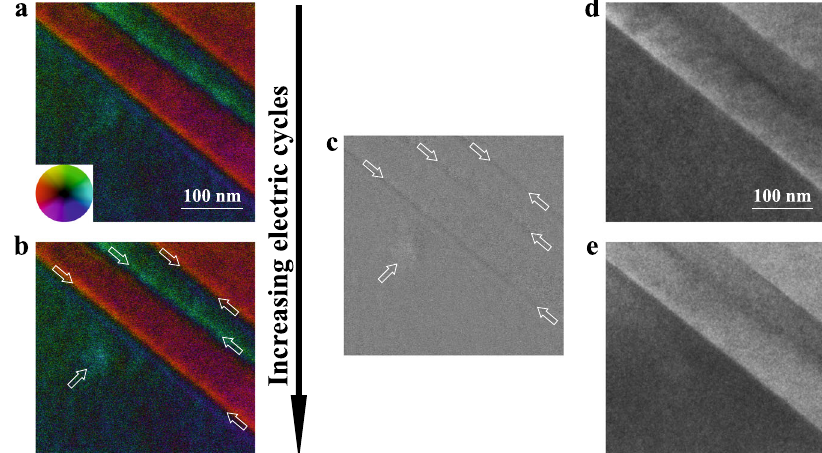
Fig. 3 Charge accumulation at domain walls during cyclic electric loadings. a , b Electric fi eld mapping before and after cyclic electric loadings, respectively. The direction and amplitude of local electric fi elds are represented by colors, see the color wheel at the lower-left corner of a , and image intensity, respectively. c A grayscale image obtained from the subtraction of the image in a from the image in b , showing the variation in local image intensity. The white hollow arrows in b and c mark the places with signi fi cant intensity variation after cyclic loading. d , e TEM images before and after cyclic loadings,